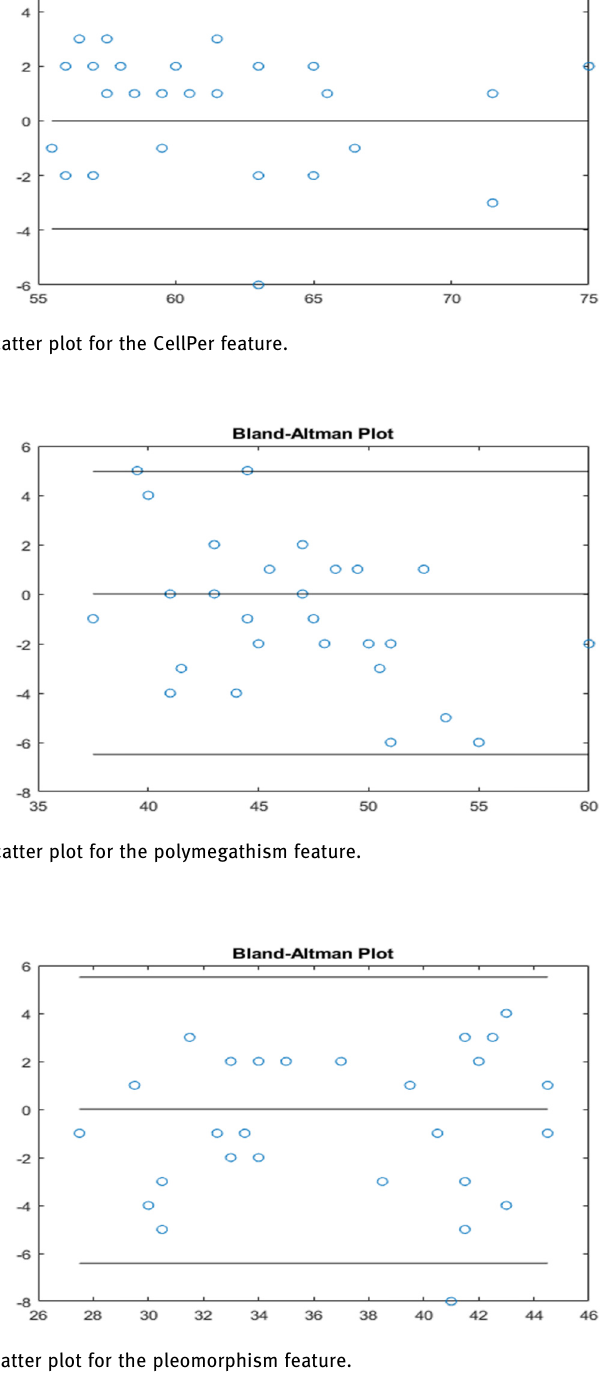
Figure 25: Bland – Altman scatter plot for the pleomorphism feature.